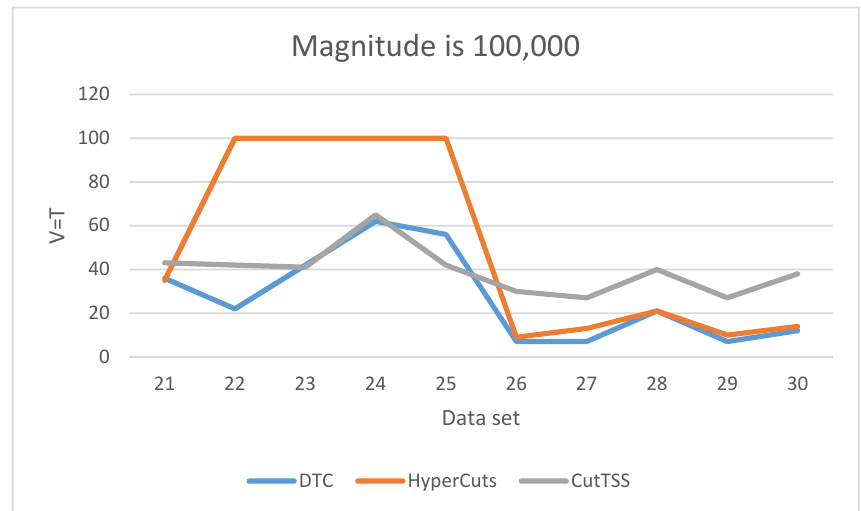
Figure 7. The experimental result when V = T and the data magnitude is 100,000.